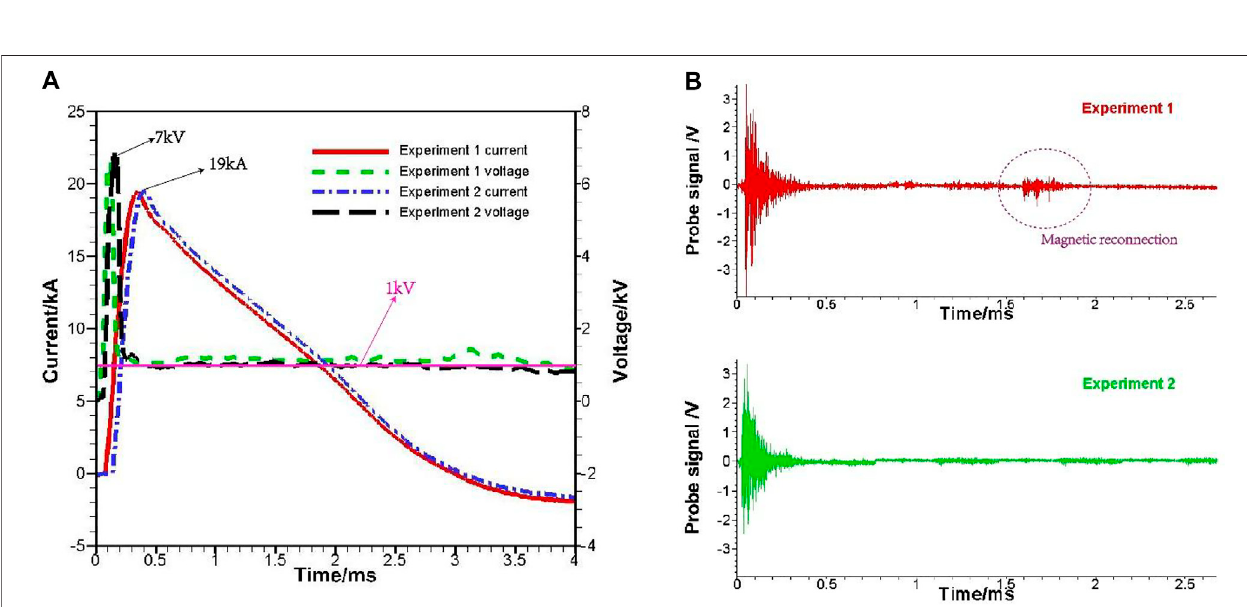
FIGURE 4 | Measured discharge waveform and magnetic probe signal in the experiments. (A) The voltage and current curves of the discharge process. (B) The magnetic probe signal of the discharge process.